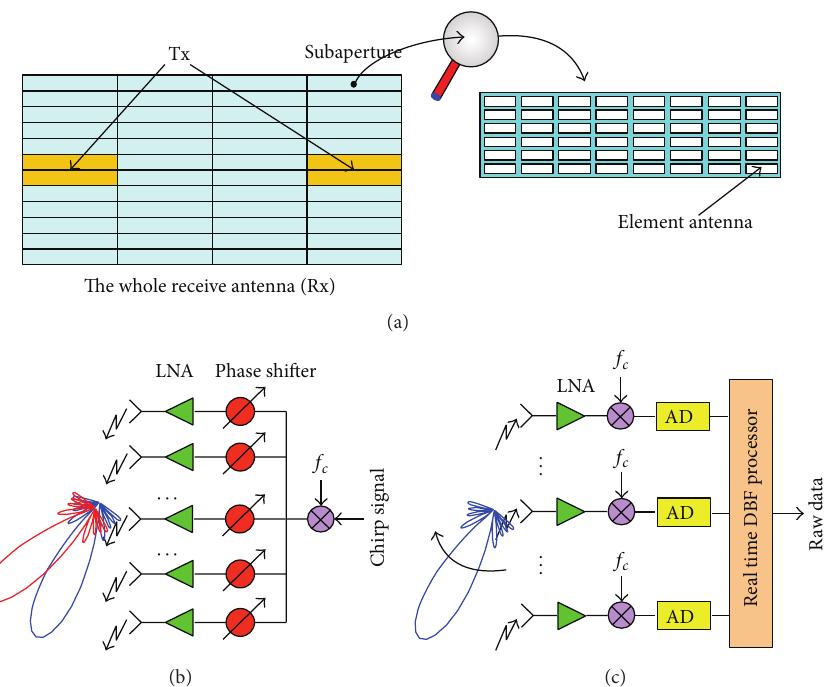
Figure 3: A large antenna adopted in beamspace MIMO-SAR. (a) The large receive antenna is divided into multiple subapertures in both azimuth and elevation directions, and each subaperture contains lots of element antenna. (b) Intrapulse beamsteering to transmit multiple subpulses via the ABF net. (c) Sharp pencil beam to receive echoes by a real DBF